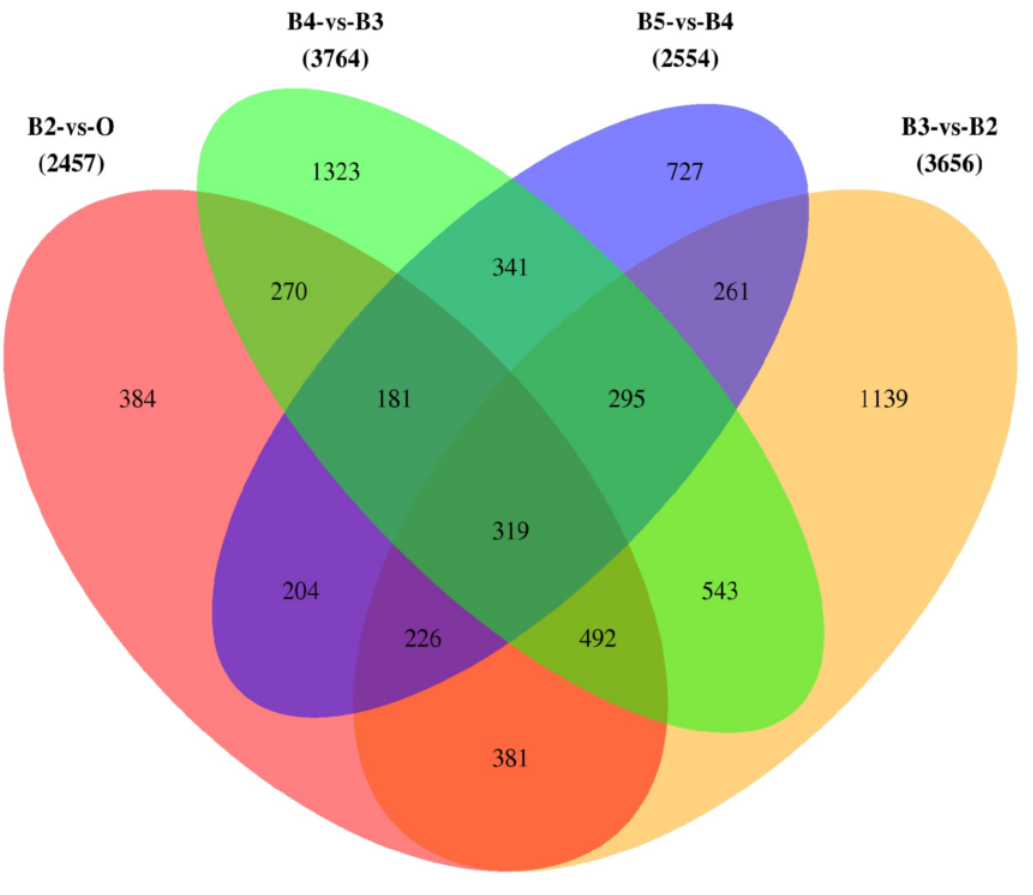
Figure 2. A Venn diagram showing the shared and unique genes between different groups.